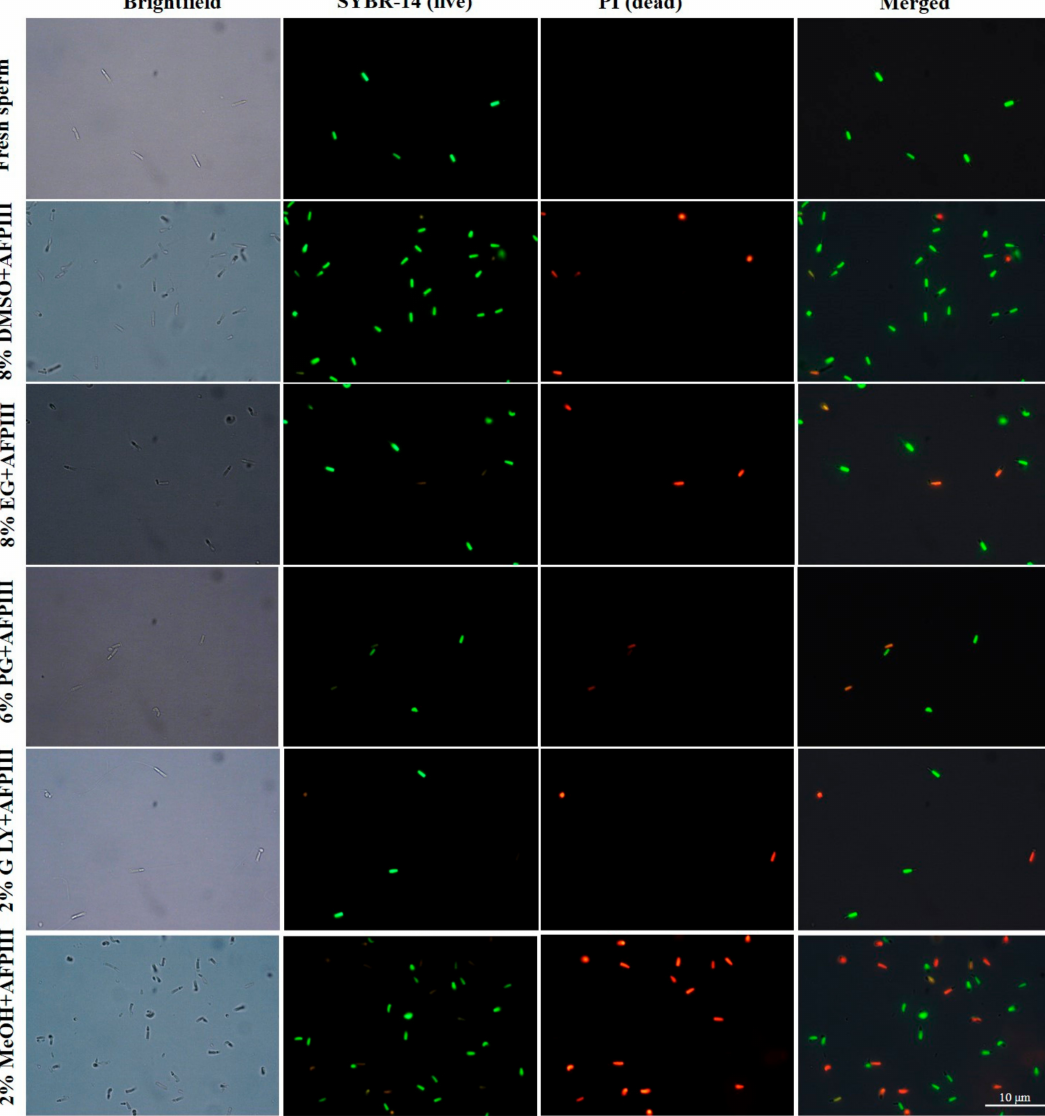
Figure 3. Fluorescent stained photographs for detecting plasma membrane integrity of sperm cryopreserved with AFPIII (1000 ×